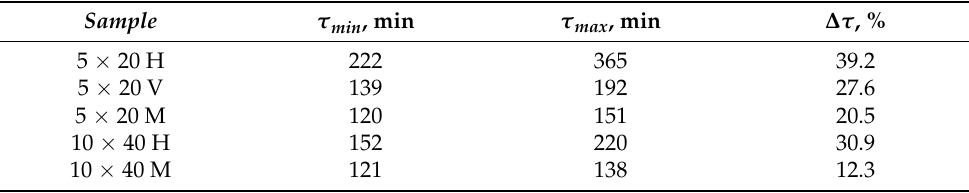
Table 2. Heating times of individual samples in a furnace with the temperature of 750 ◦